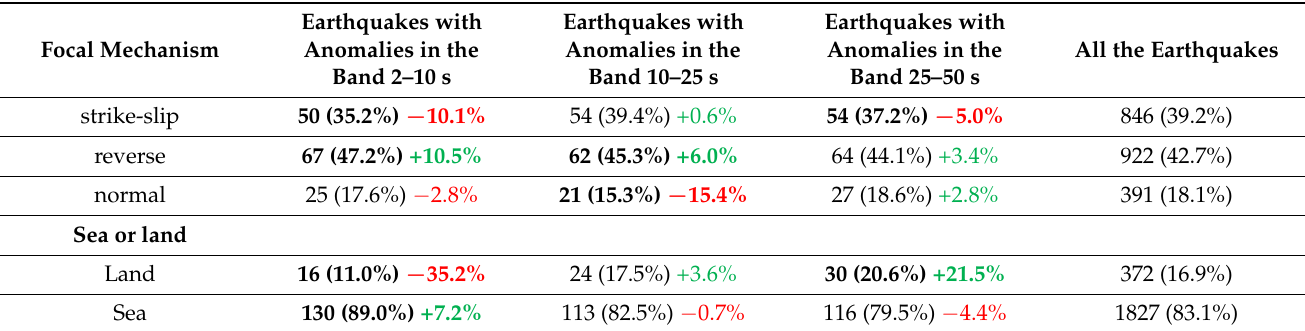
Table 3. Investigation of a possible relation with the focal mechanism with the recorded frequency of the magnetic field anomalous signals from the Swarm and sea or land epicenter location. The significant percentage of deviation from the standard earthquake distribution (i.e., the ones ≥ 5% in their absolute value) are marked by bold numbers. Green (red) numbers represent positive (negative) deviation percentages with respect to the